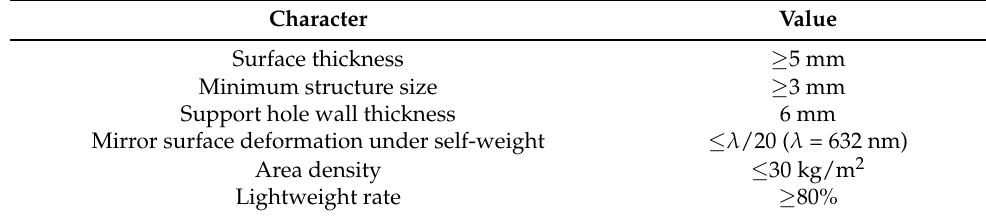
Table 2. Mirror design constraints.